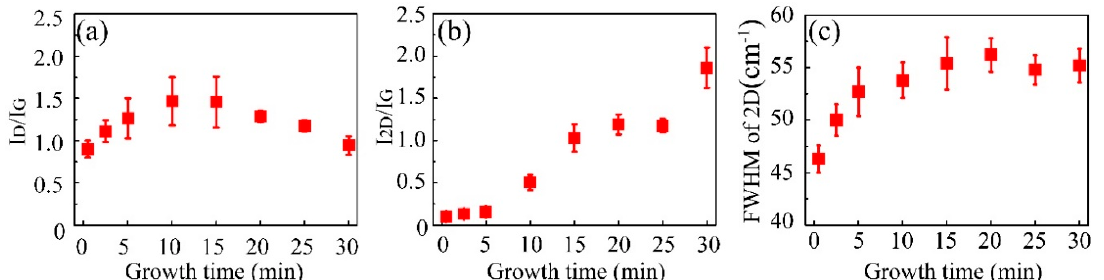
Figure 4. Detailed parameters derived from the Raman spectra of the graphene that was directly grown on the 300 nm SiO 2 /Si substrate ( a ) I D /I G , ( b ) I 2D /I G, and ( c ) FWHM (2D), respectively.